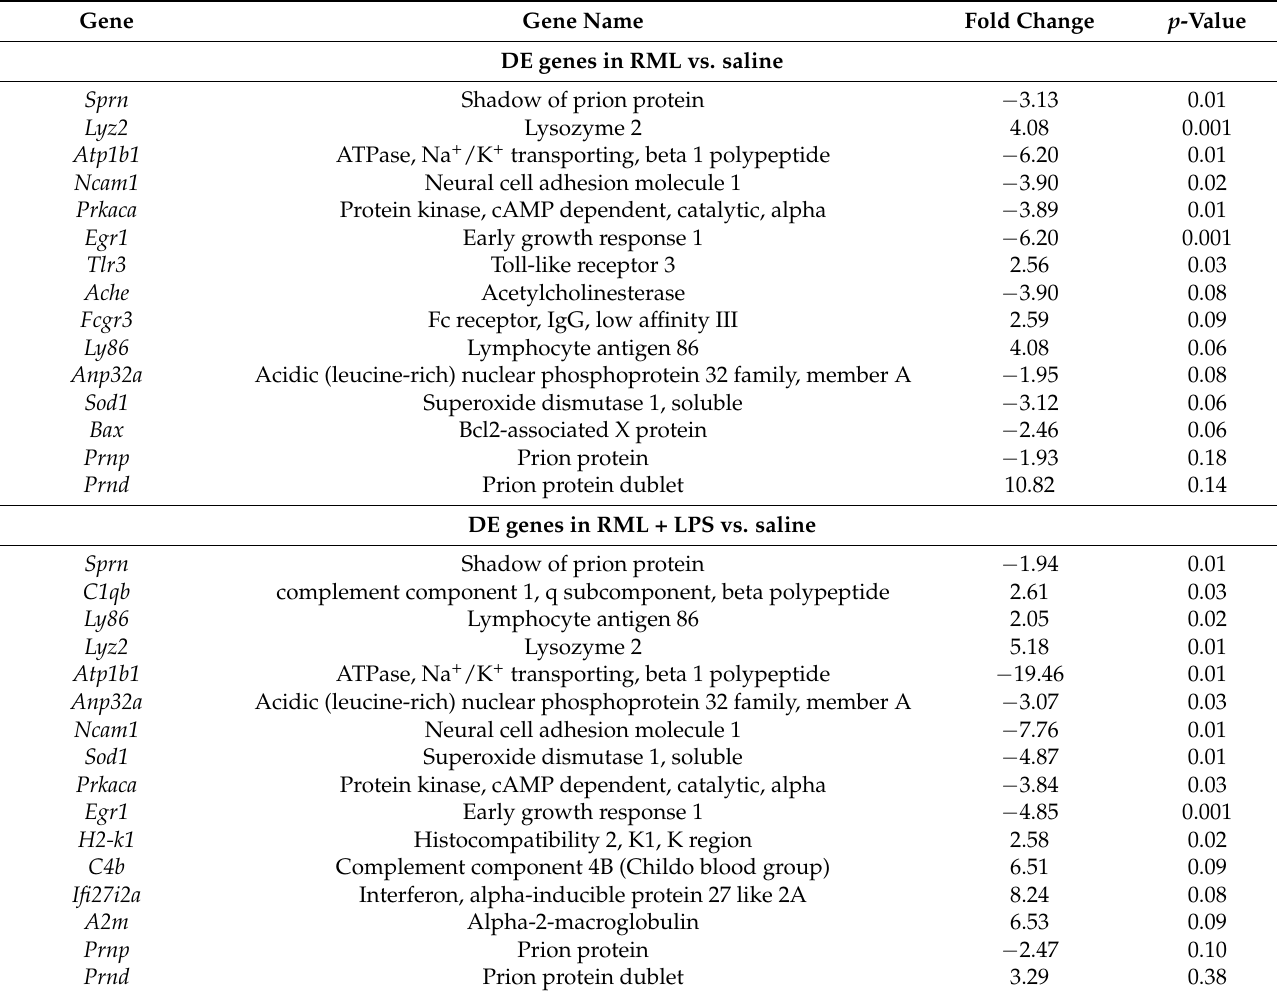
Table 4. List of differentially expressed genes in brain tissue of terminally sick mice after RML and RML/LPS injection. Gene Gene Name Fold